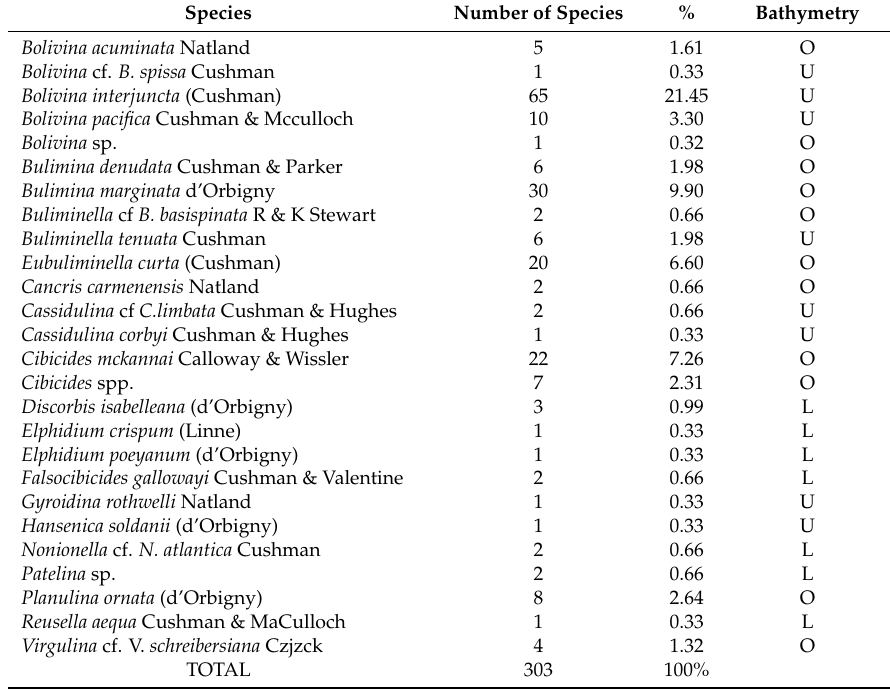
Table 1. Benthic foraminifera species diversity and dominance from a 50-gr. sample collected on the south shore of Ensenada San Basilio (26 ◦ 20 (cid:48) 54” N and 111 ◦ 25 (cid:48) 14” W). Abbreviations: L = littoral-inner shelf biofacies (0–50 m); O = outer shelf to shelf edge biofacies (50–150 m); U = upper bathyal biofacies (150–500 m).